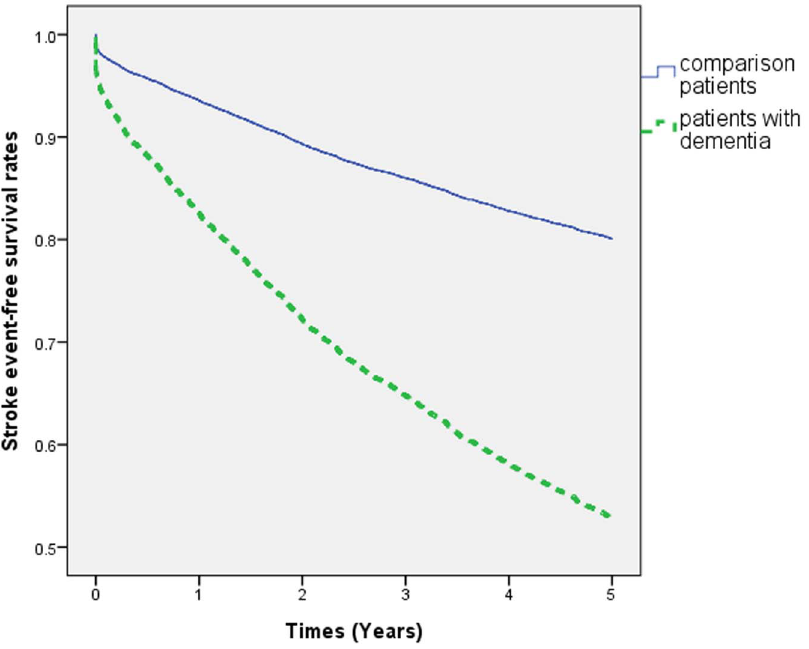
Figure 1. Stroke-free survival rates for patient with dementia and comparison group in Taiwan between 2003 and 2005.